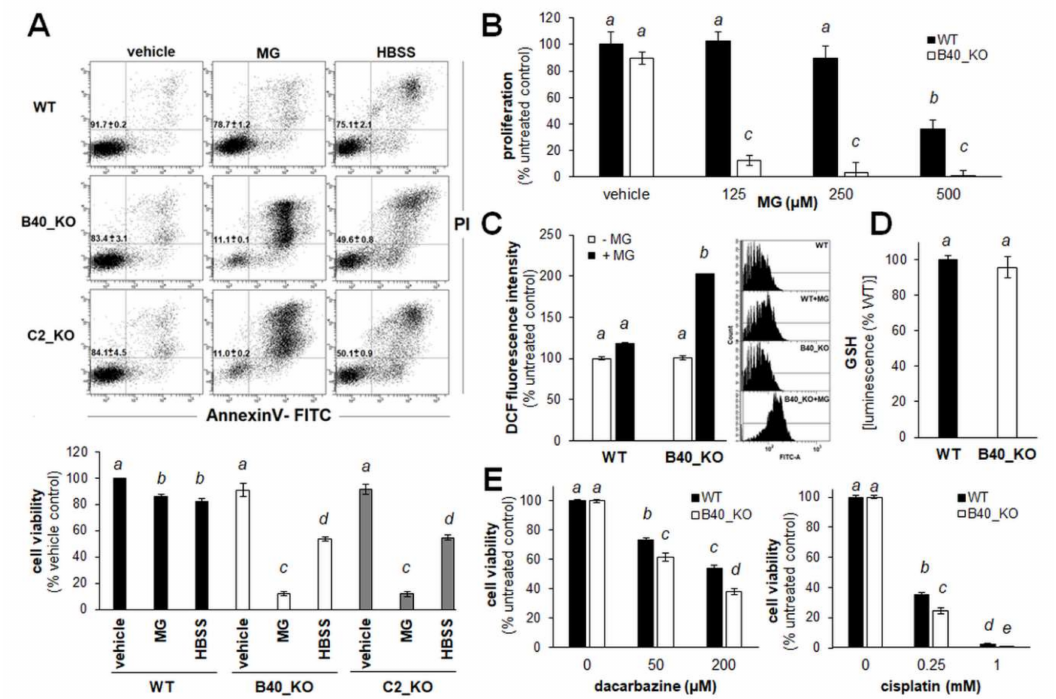
Figure 2. Human A375 malignant melanoma cells with genomic GLO1 deletion (A375- GLO1 _KO) display significant sensitization to methylglyoxal (MG)-, chemotherapy-, and starvation-induced cytotoxic stress. ( A ) Impairment of cellular viability (WT, B40_KO, C2_KO) in response to MG (500 µ m, 24 h) or serum starvation (HBSS, 24 h) monitored using flow cytometric analysis (annexin V-PI staining). Numbers in quadrants indicate percentage of viable cells (AV negative, PI negative) from a total of gated cells (mean ± SD). Bar graph indicates cell viability as a function of treatment and GLO1 deletion. ( B ) MG-induced impairment of cellular proliferation (WT, B40_KO; ≤ 500 µ m, 72 h). ( C ) MG-induced oxidative stress (WT, B40_KO; 500 µ m, 2 h), as monitored by flow cytometric detection of DCF fluorescence. Left panel: bar graph; right panel: one set of histograms representative of three repeats is shown. ( D ) Intracellular reduced glutathione content (luminescence intensity) normalized to cell number (WT, B40_KO; mean ± SD). ( E ) Impairment of cell viability (WT, B40_KO) in response to dacarbazine ( ≤ 200 µ m, 24 h; left panel) and cisplatin ( ≤ 1 mM, 24 h; right panel). For bar graph statistical analysis with letter designation see Materials and Methods Section